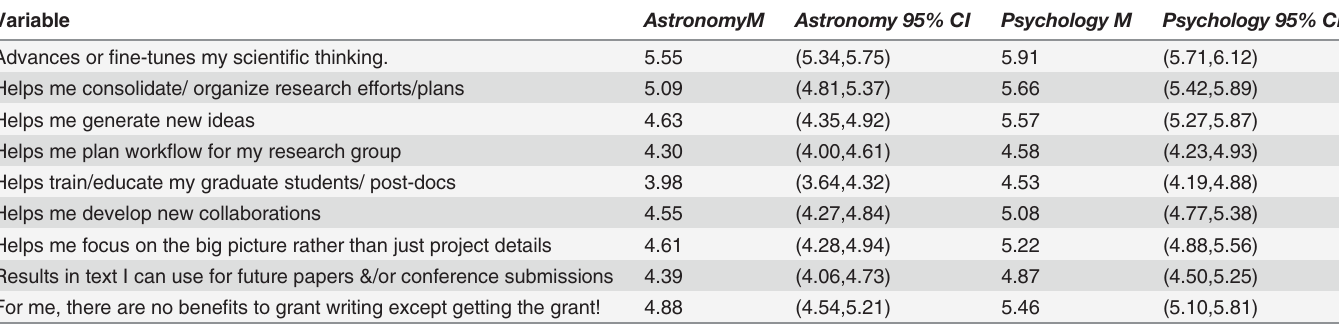
Table 2. Summary of Means and 95% Con fi dence Intervals of Individual Bene fi ts of Applying for Grants for Astronomers and Psychologists.